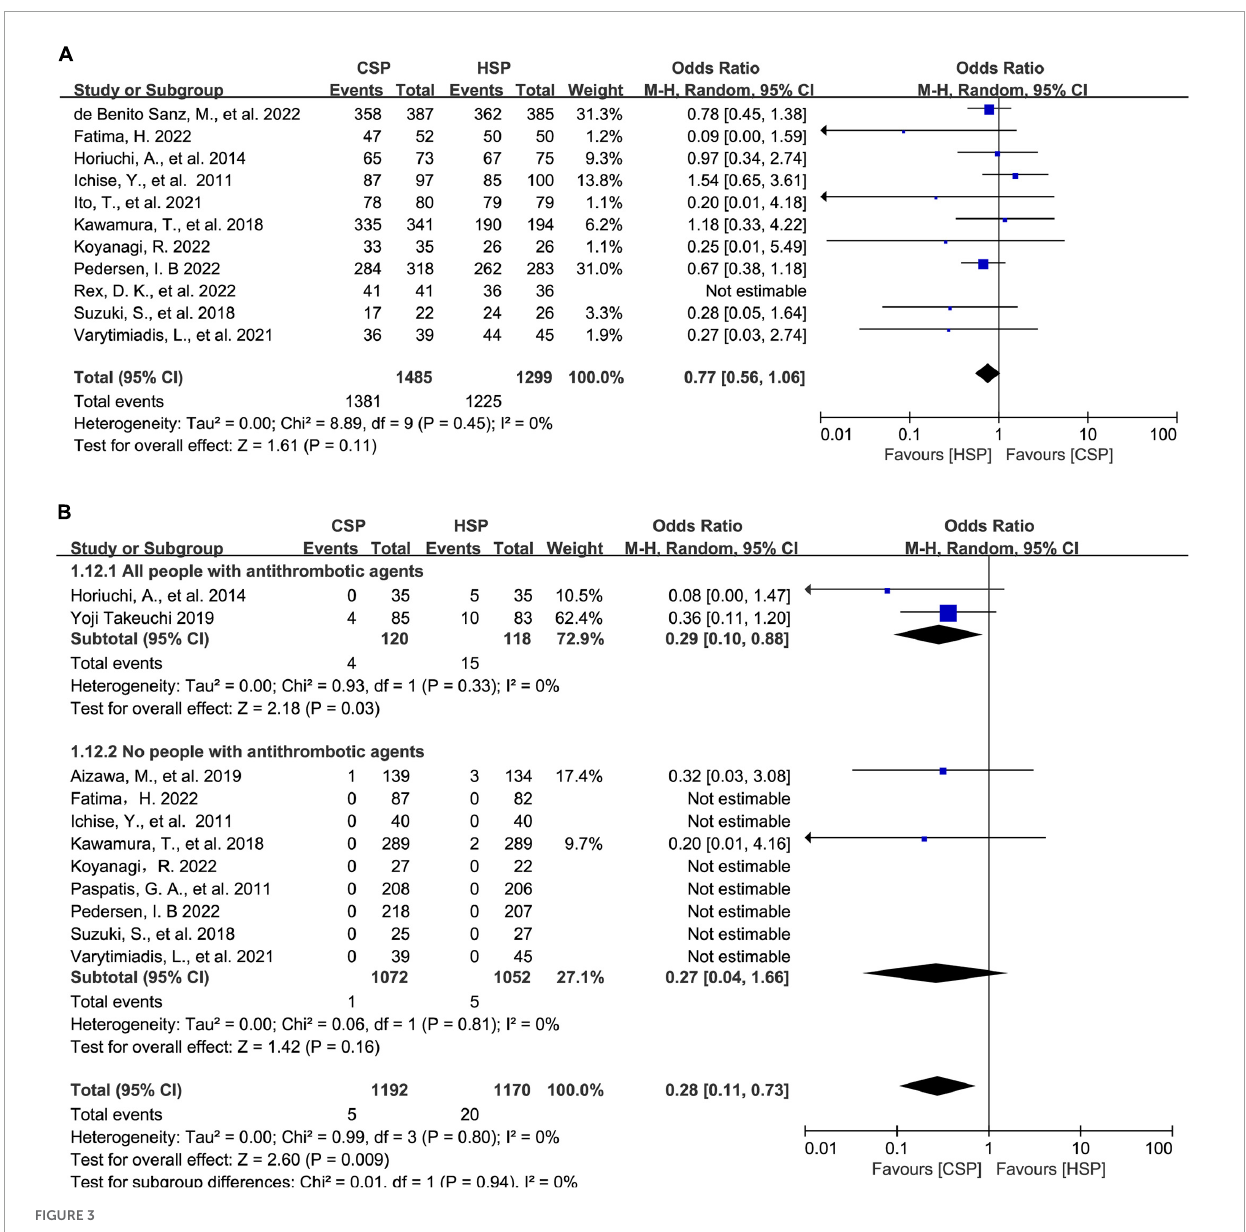
FIGURE3 Direct meta-analysis and subgroup analysis comparing hot snare polypectomy (HSP) and cold snare polypectomy (CSP) for polyps of < 10 mm. (A) Forest plot of complete resection rate. (B) Forest plot of major post-polypectomy bleeding rate: subgroups of patients on/not on antithrombotic agents.